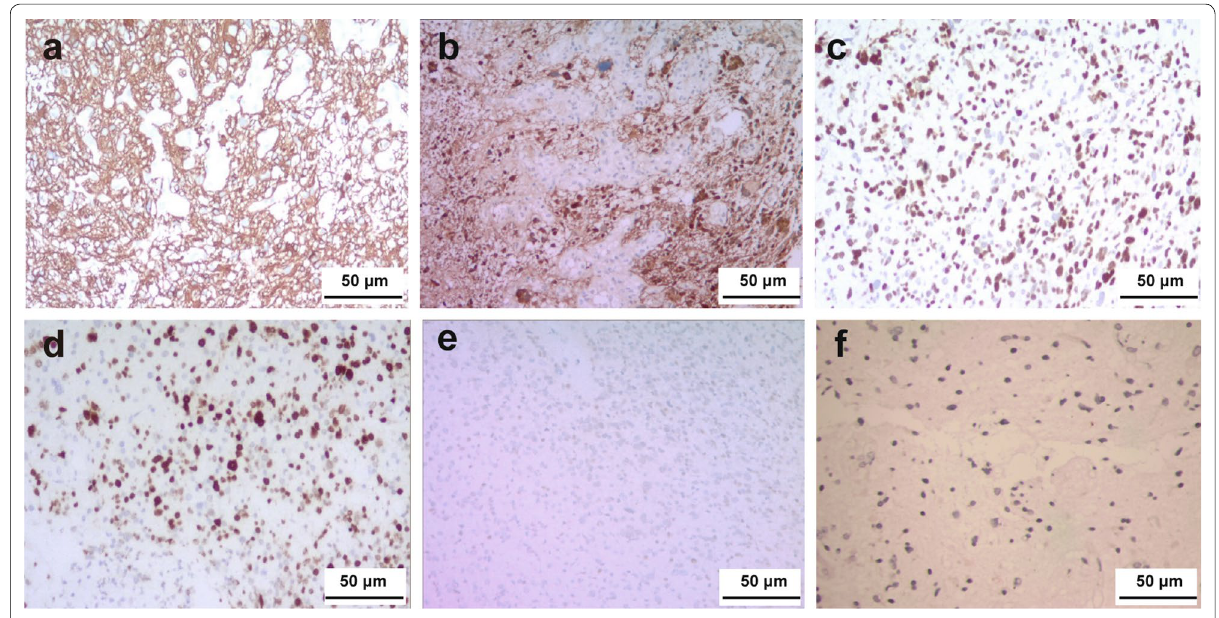
Fig. 4 Immunohistochemical examination of the tumor with diaminobenzidine staining. Glial fibrillary acidic protein ( a ), S-100 ( b ), P53 ( c ), and Ki-67 ( d ) are diffusely expressed. The expression of methylated O6-methylguanine-DNA methyltransferase ( e ) and isocitrate dehydrogenase 1 ( f ) is